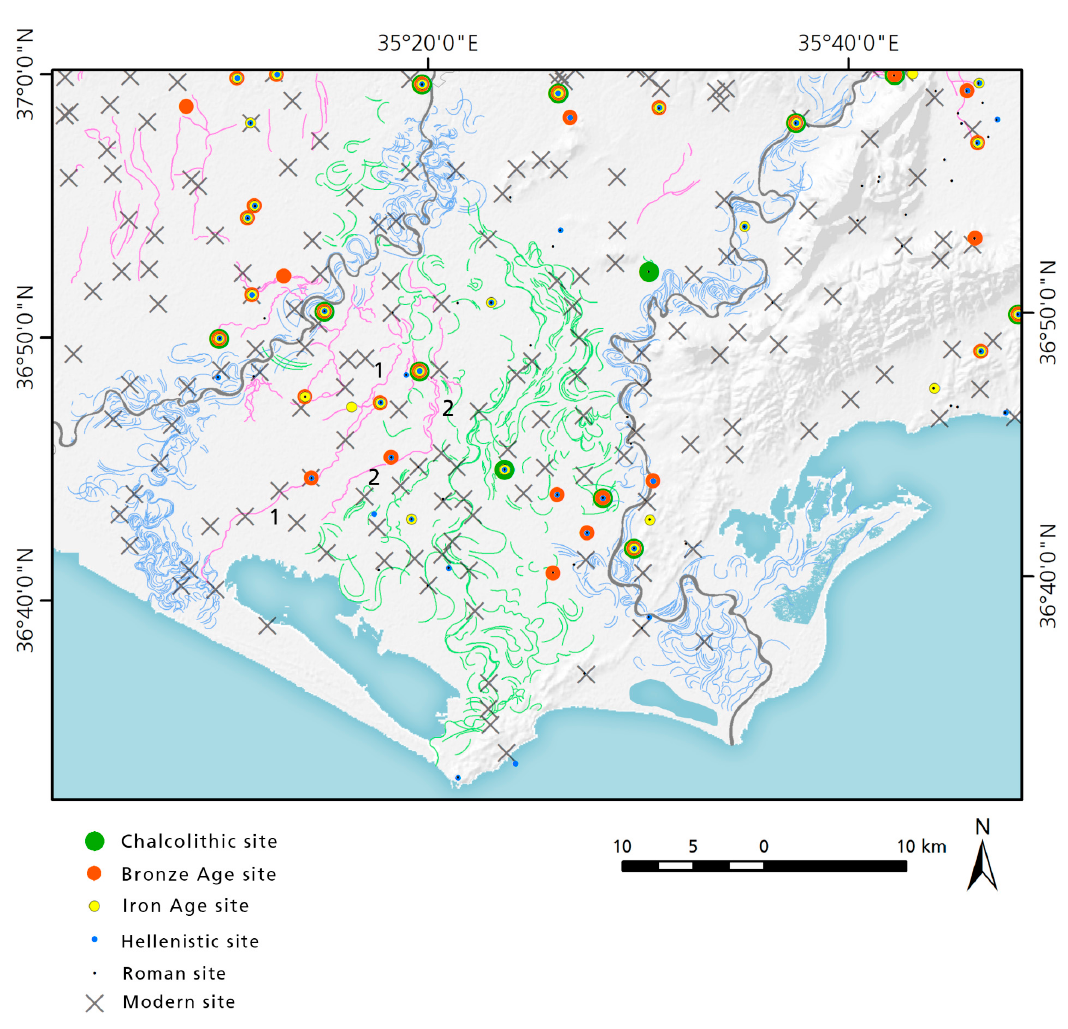
Figure 15. Location of archaeological and modern sites in the Çukurova. Modern river courses (grey), palaeochannels (blue, green) and relict canals (pink) in the Çukurova © Susanne Rutishauser.